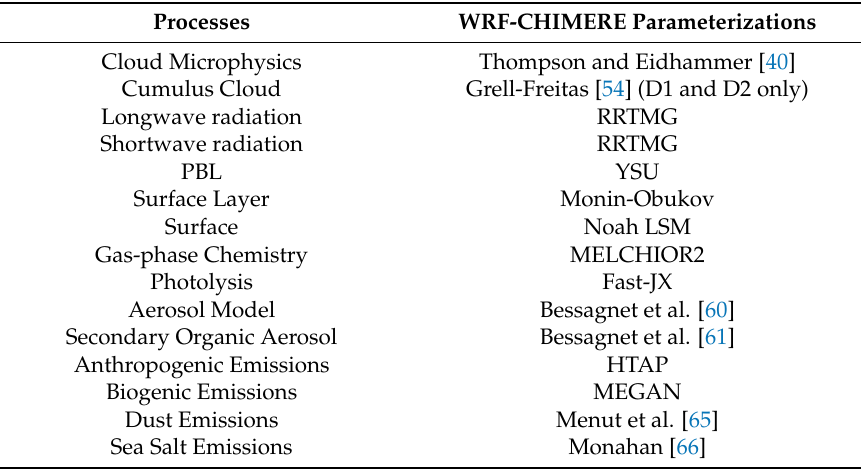
Table 1. Physical and chemical parameterizations used for WRF and